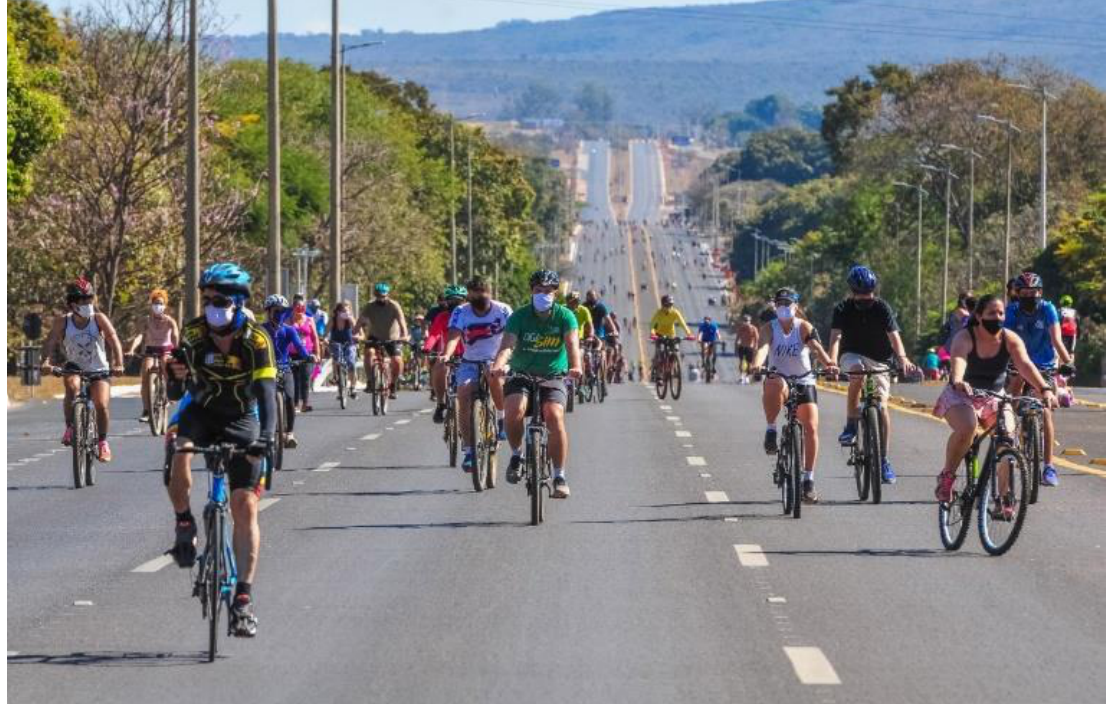
Figure 10: ‘Eixão do Lazer’, a highway closed for cart traffic on Sundays during the pandemic, in August 2020. (Photo credit: Acacio Pinheiro/Agencia